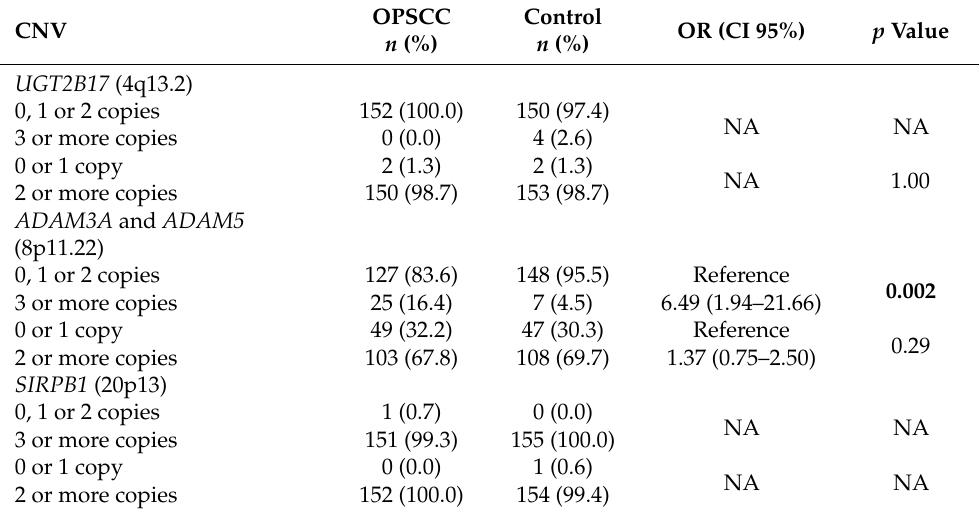
Table 1. Copy number variations in the UGT2B17 , ADAM3A and ADAM5 , and SIRPB1 genes in 152 oropharyngeal squamous cell carcinoma patients and 155 controls.